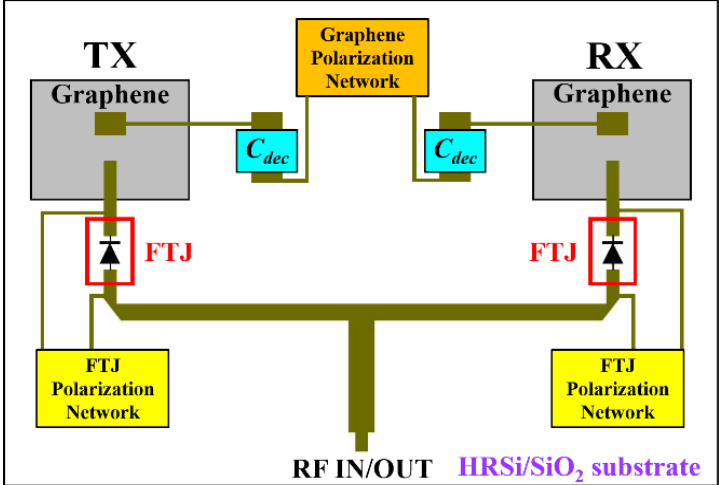
Figure 13. Schematic design of the “smart” transmitter/receiver (T/R) module in the X band, encompassing two FTJ-based microwave switches, two graphene patch antennas and the polarization networks for antennas and switches.